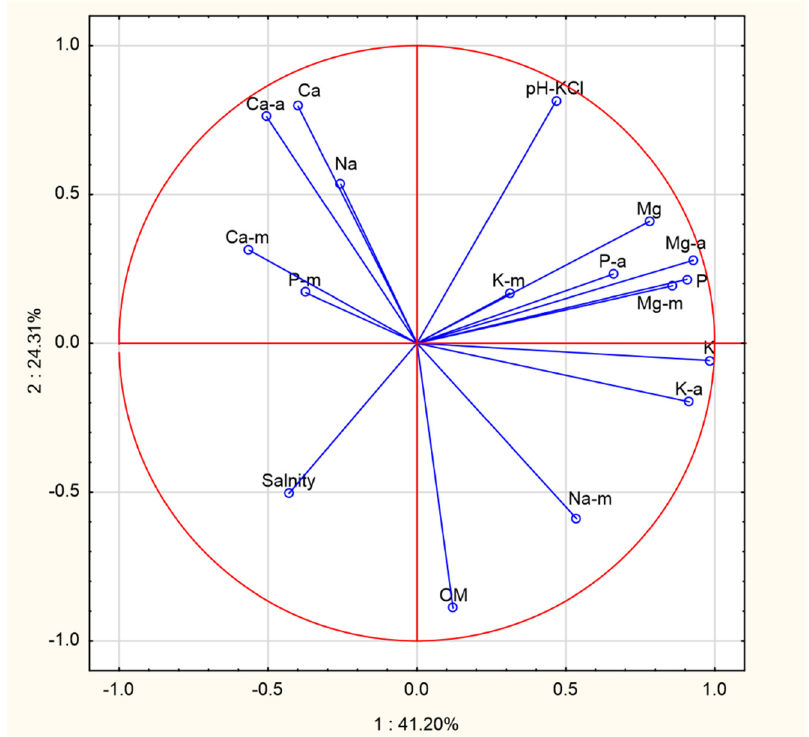
Figure 1. The principal component analysis (PCA) for soil and mushroom chemical composition (K-m—mushrooms, K-a—available, K—total, OM—organic matter). Fungi uptake very high amounts of potassium, generally higher than other elements.